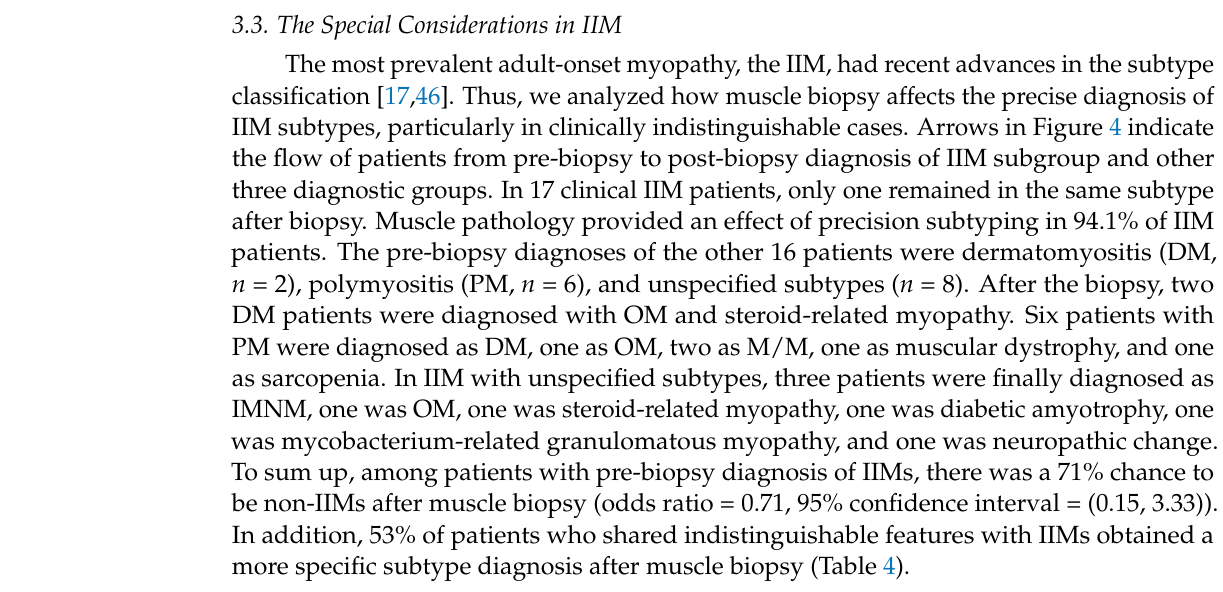
Table 4. Change of pre- and post-biopsy diagnosis in patients with idiopathic inflammatory